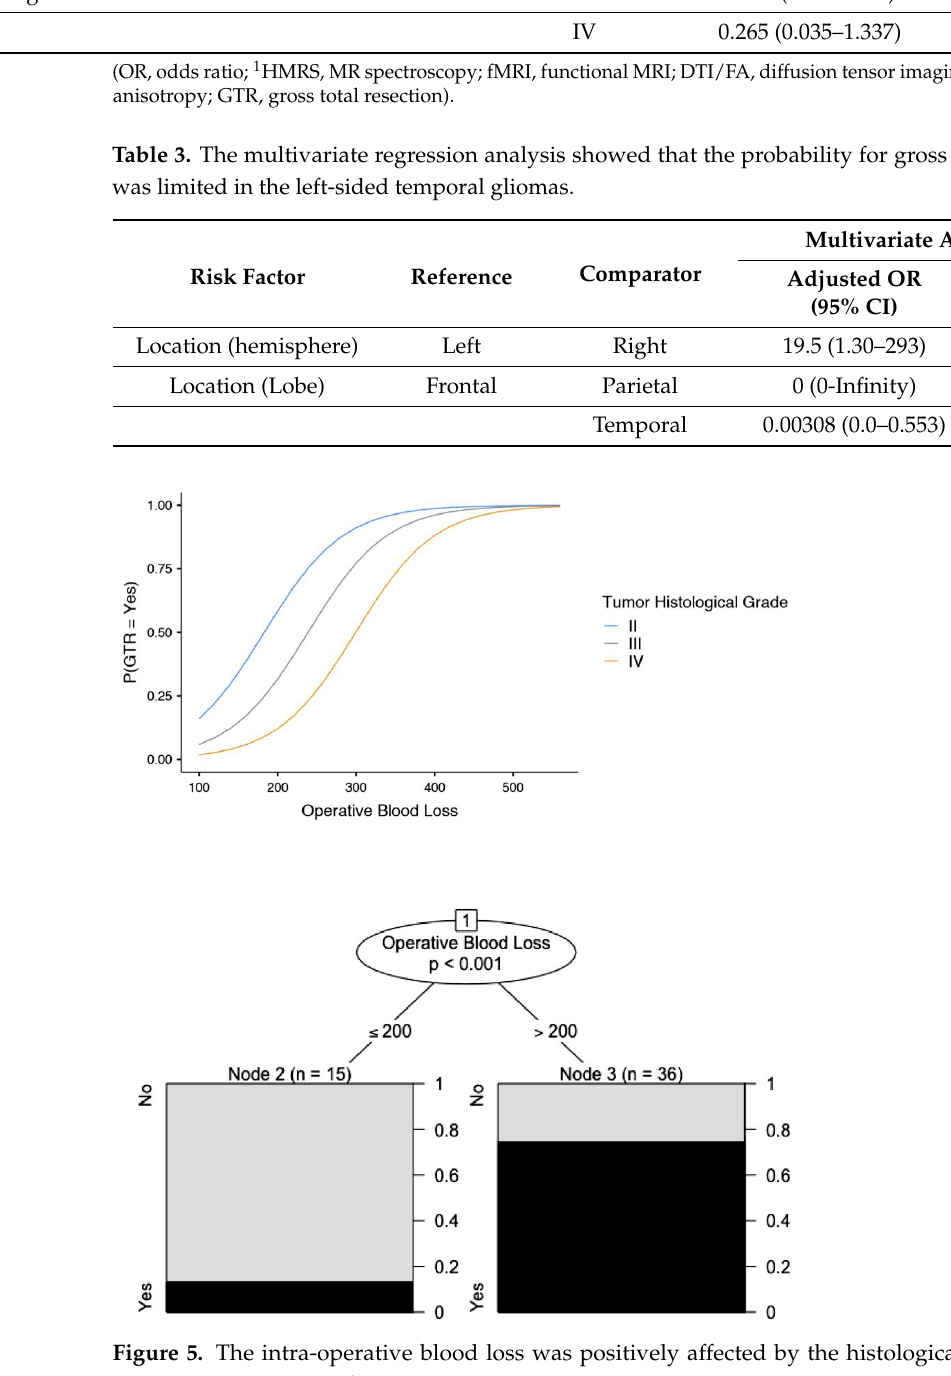
Figure 5. The intra-operative blood loss was positively affected by the histological grade of the gli- oma and the extent of